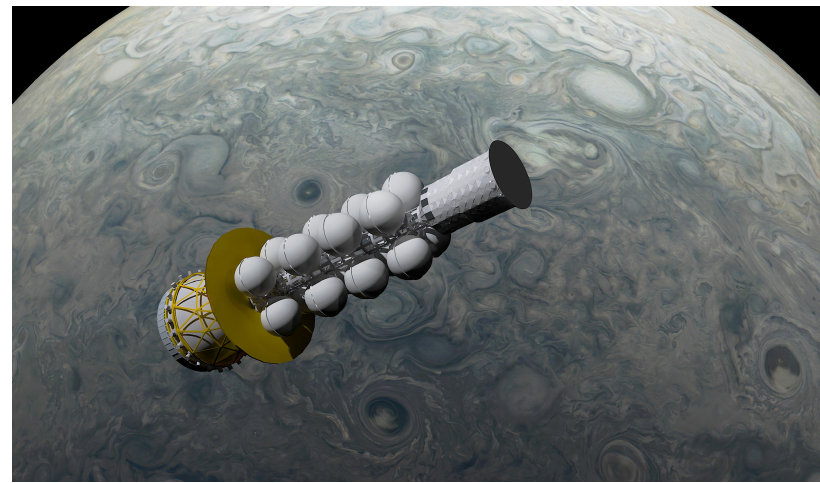
Figure 11. The Resolution spacecraft concept design.